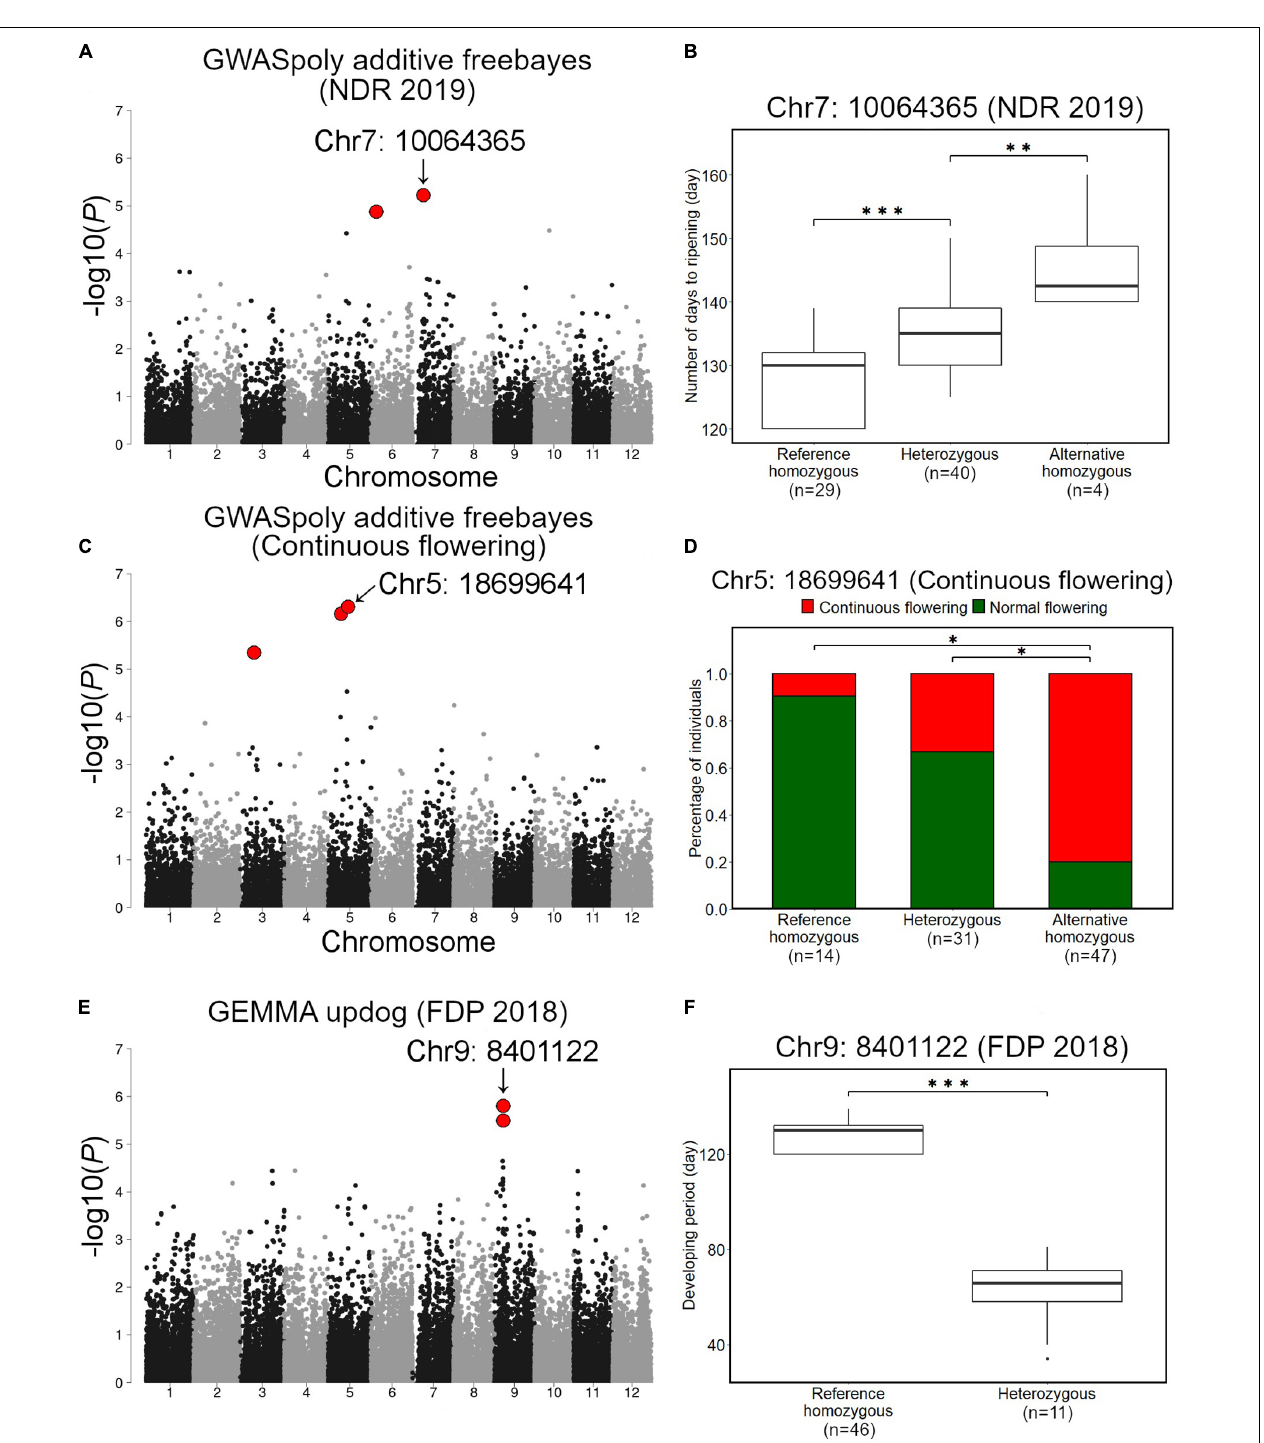
FIGURE 7 | Association studies for ripening date, continuous flowering, and fruit development period (FDP). (A,B) Associations with ripening date. (A) GWAS result for ripening date in 2019 by GWASpoly additive model with haplotype-based genotype call. (B) Comparison of ripening date in 2019 based on the genotypes at the significant locus, Chr7: 10064365. (C,D) Associations with continuous flowering. (C) GWAS result for continuous flowering by GWASpoly additive model with haplotype-based genotype call. (D) Comparison of percentage of accessions with continuous flowering habit based on the genotypes at Chr5: 18699641. (E,F) Association with fruit development period. (E) GWAS result for fruit development period by GEMMA with continuous genotype call. (F) Comparison of fruit development period based on the genotypes at Chr9: 8401122. Red dots in (A,C,E) represent significant phenotype-genotype associations (FDR < 0.1). Asterisks ( ∗ and ∗∗∗ ) in (B,D,F) represent significant difference ( p < 0.05 and p < 0.001, respectively).